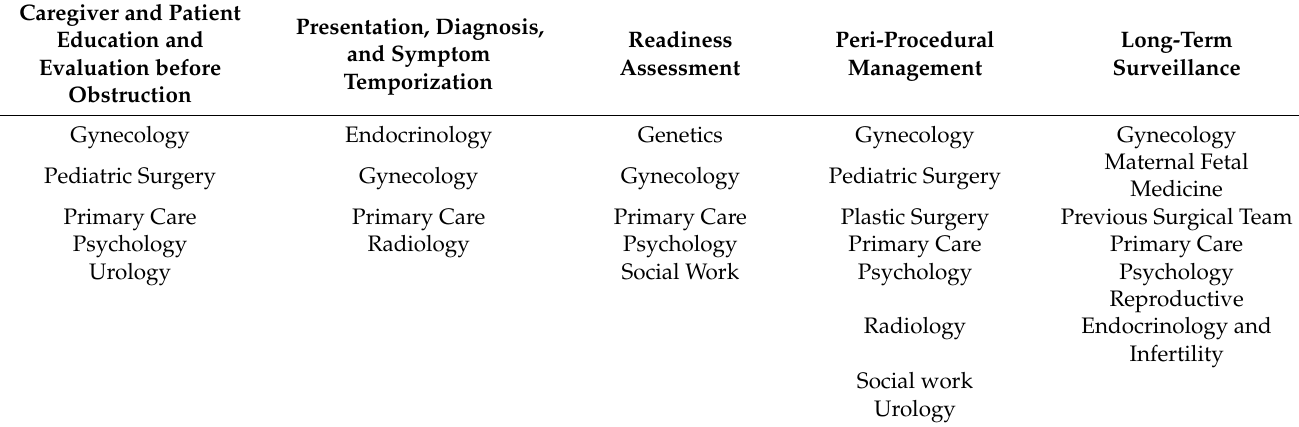
Table 1. Medical and Surgical Specialty Involvement at the Different Phases of Müllerian Outflow Tract Obstruction (specialties listed in alphabetical